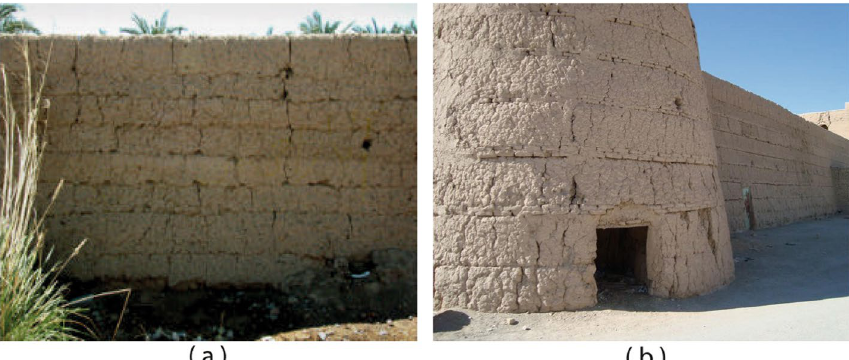
Fig. 11 The vernacular technique of Chineh: ( a ) an example of acceptable performance during the Bam earthquake (Source: Langenbach 2004) and ( b ) wall stabilisation by brick courses, Abarkuh, Yazd (Source: the authors)